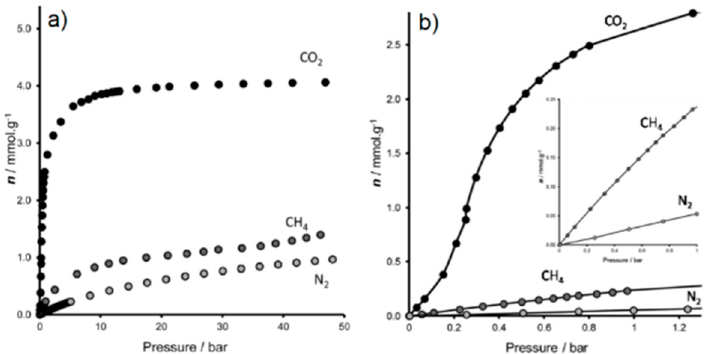
Figure 26. CO 2 , CH 4 , and N 2 adsorption isotherms measured at 303 K on MIL-91(Al) up to 50 bar ( left ) and up to 1 bar ( right ). Adapted with permission from reference. [69]. Copyright 2015, American Chemical Society.